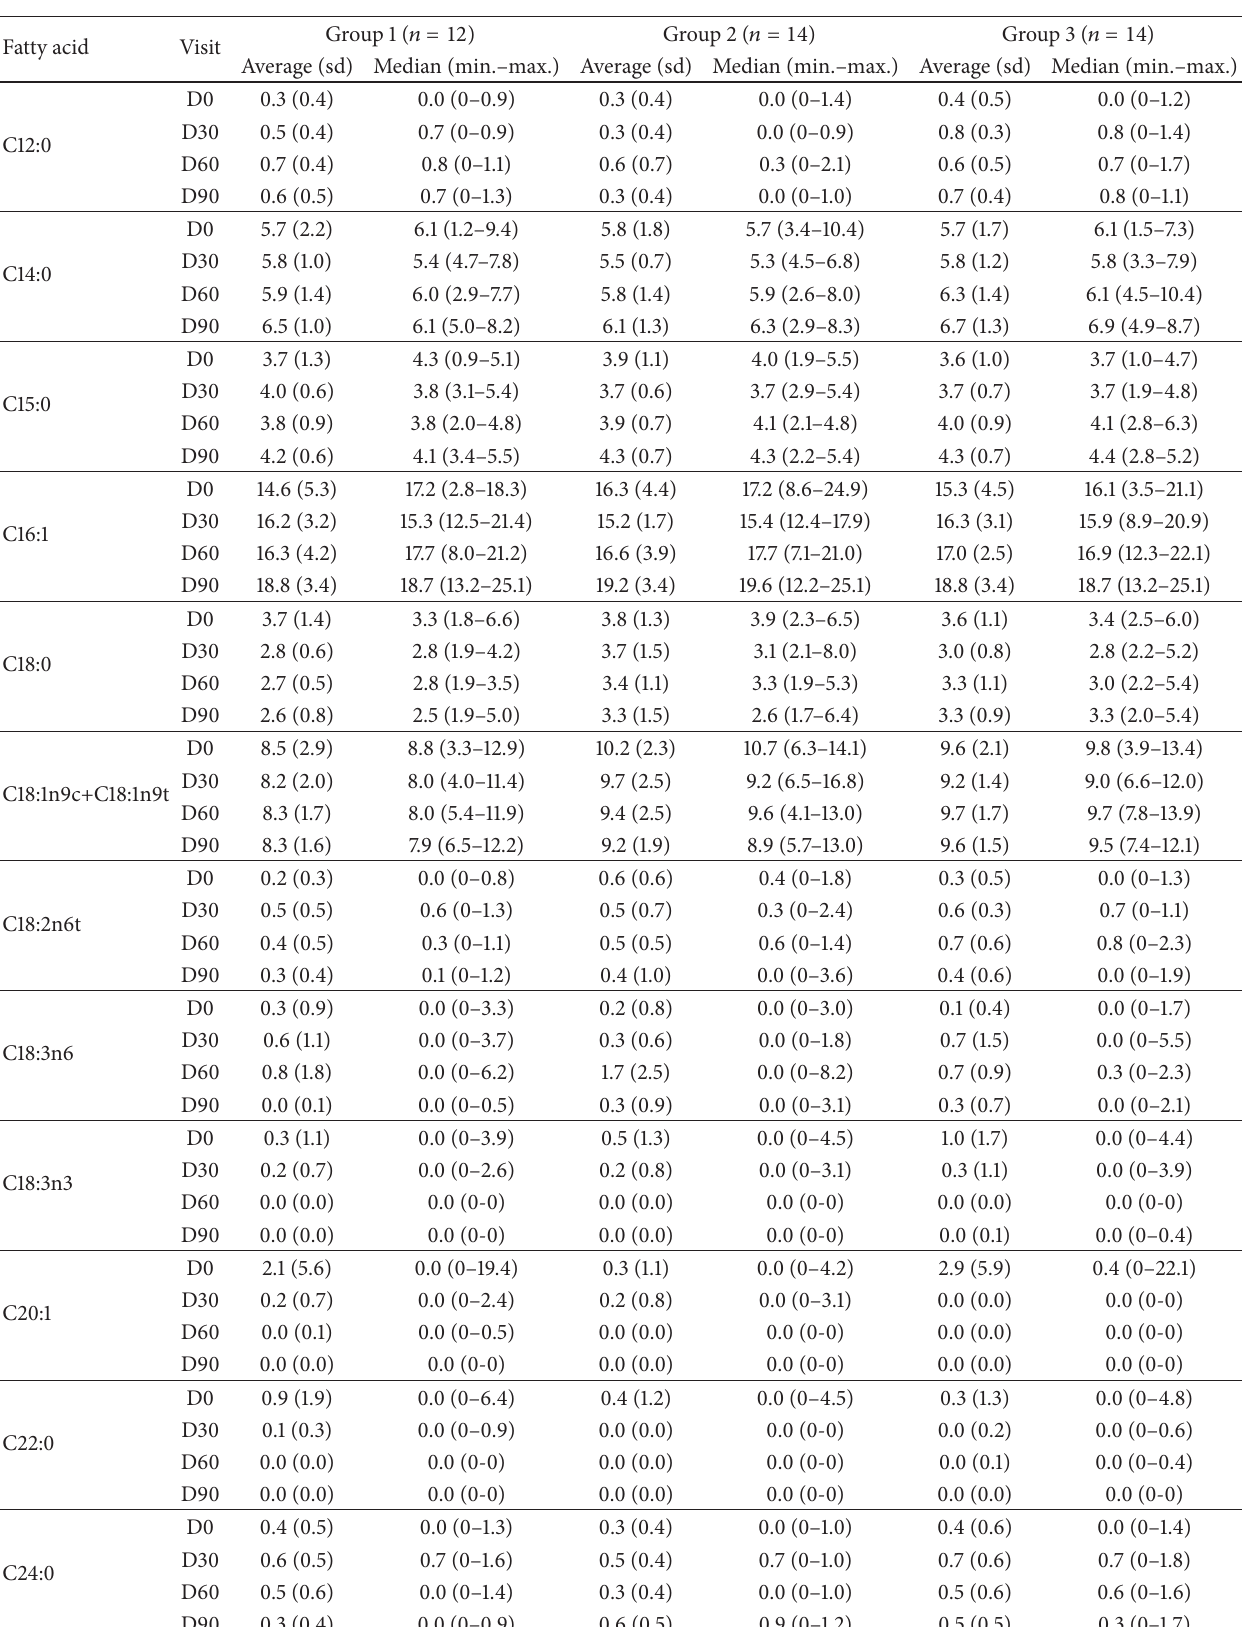
Table 2: Descriptive statistic of twelve fatty acids that presented changes during the study, based on group treatment and visits. Fatty